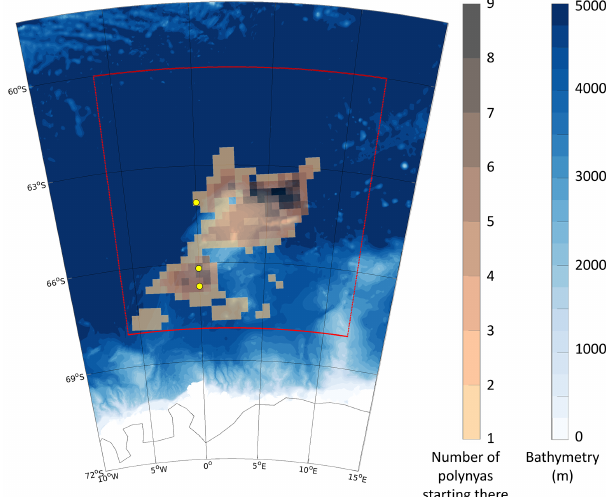
Figure 3. Out of the 30 polynyas detected, the number of those that start at each location (transparent shading). Background: bathymetry of the region from GEBCO Compilation Group (2019). Red contours indicate the polynya-prone region studied in this pa- per. Yellow dots mark the location of the three moorings used in Sect. 4: AWI229 (north), AWI230 (middle), and AWI231 (south).